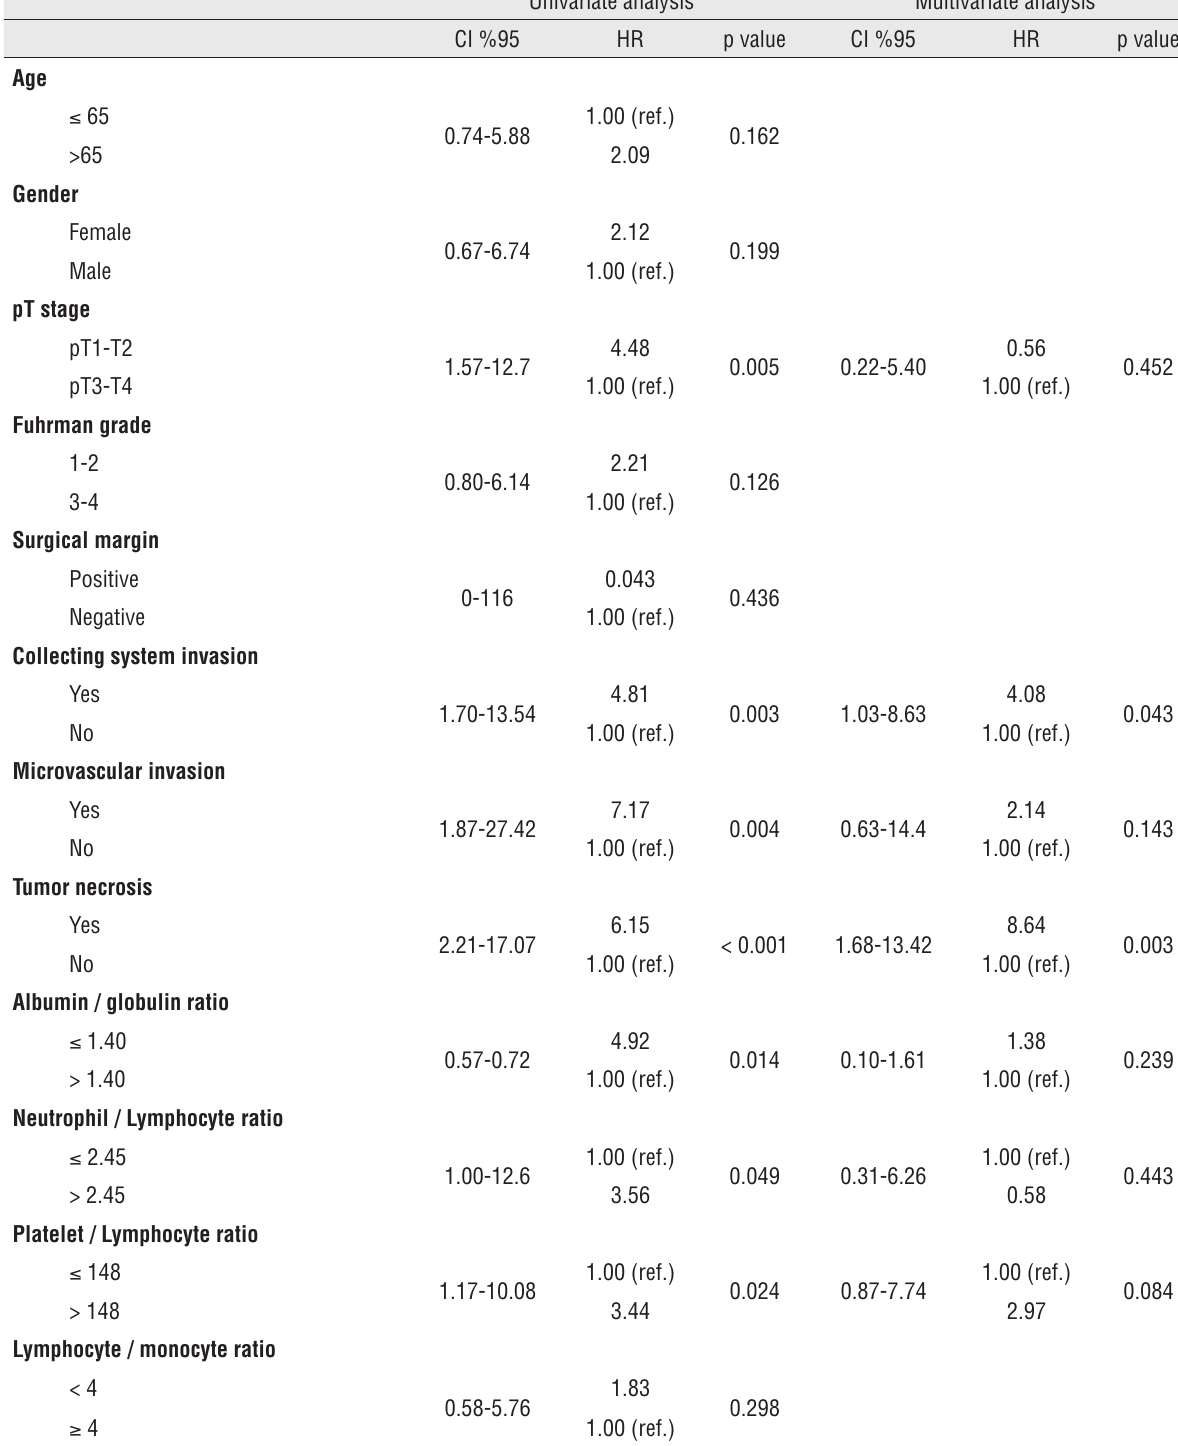
Table 4 - Univariate and multivariate Cox regression analyses of prognostic factors for overall survival. Univariate analysis Multivariate analysis CI